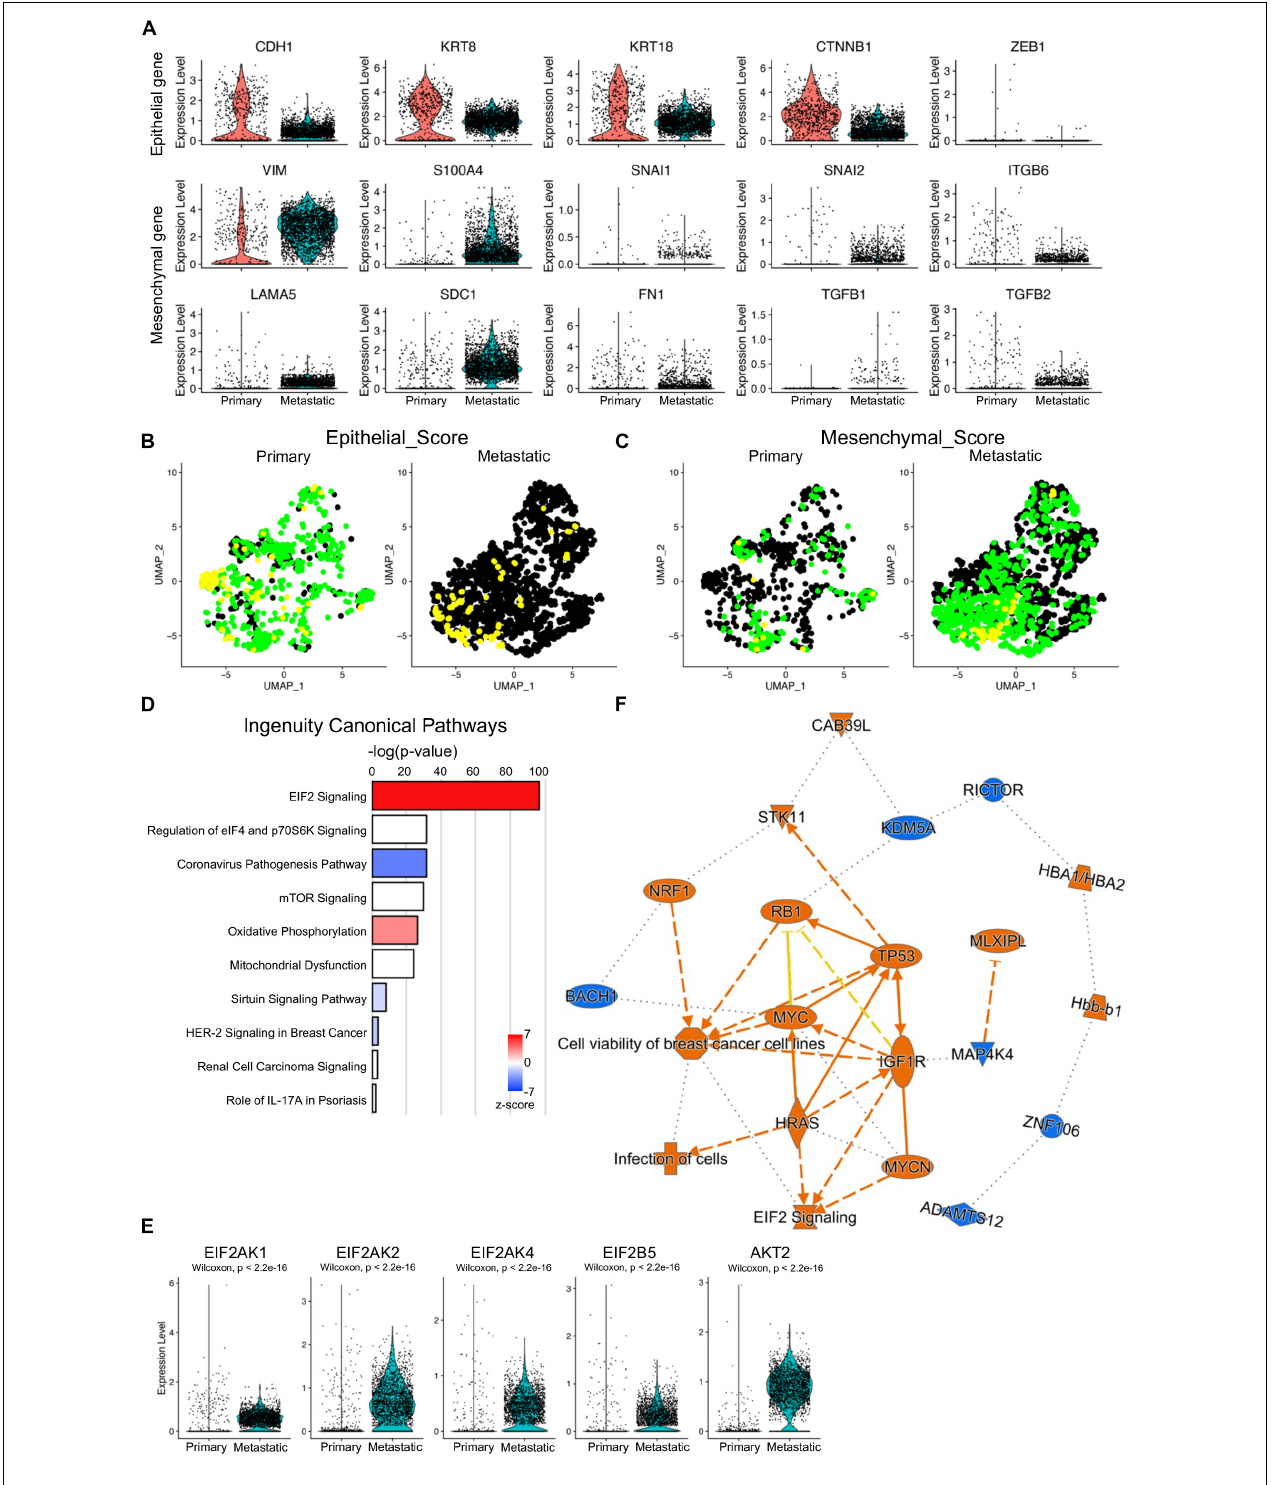
FIGURE 7 | Increased EMT activities and activated EIF2 signaling in metastatic cancer cells. (A) Violin plot visualization of representative EMT marker gene expression in primary and metastatic cancer cells. (B,C) UMAP visualization of epithelial (B) and mesenchymal (C) scores of the primary and metastatic cancer cells. (D) Bar plots of the top ingenuity canonical pathways based on the upregulated genes of the metastatic cancer cells. (E) Increased expression of EIF2 signaling effector genes in metastatic cancer cells by violin plots. Color codes: orange, upregulated; blue, downregulated. Color shapes: different molecular/gene types. Lines: solid lines, direct regulation; dashed lines, indirect regulation. (F) Graphic regulatory networks of the top signaling pathways and regulators of metastatic cancer cells.